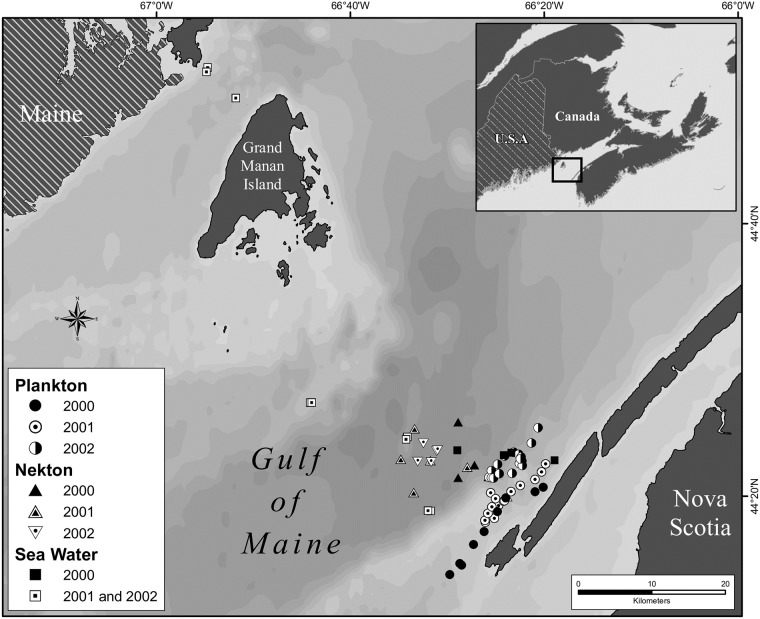
Locations in the outer Bay of Fundy where seawater, plankton and nekton collections were made, on consecutive years between 2000 and 2002, from the research vessel CCMV Navicula.